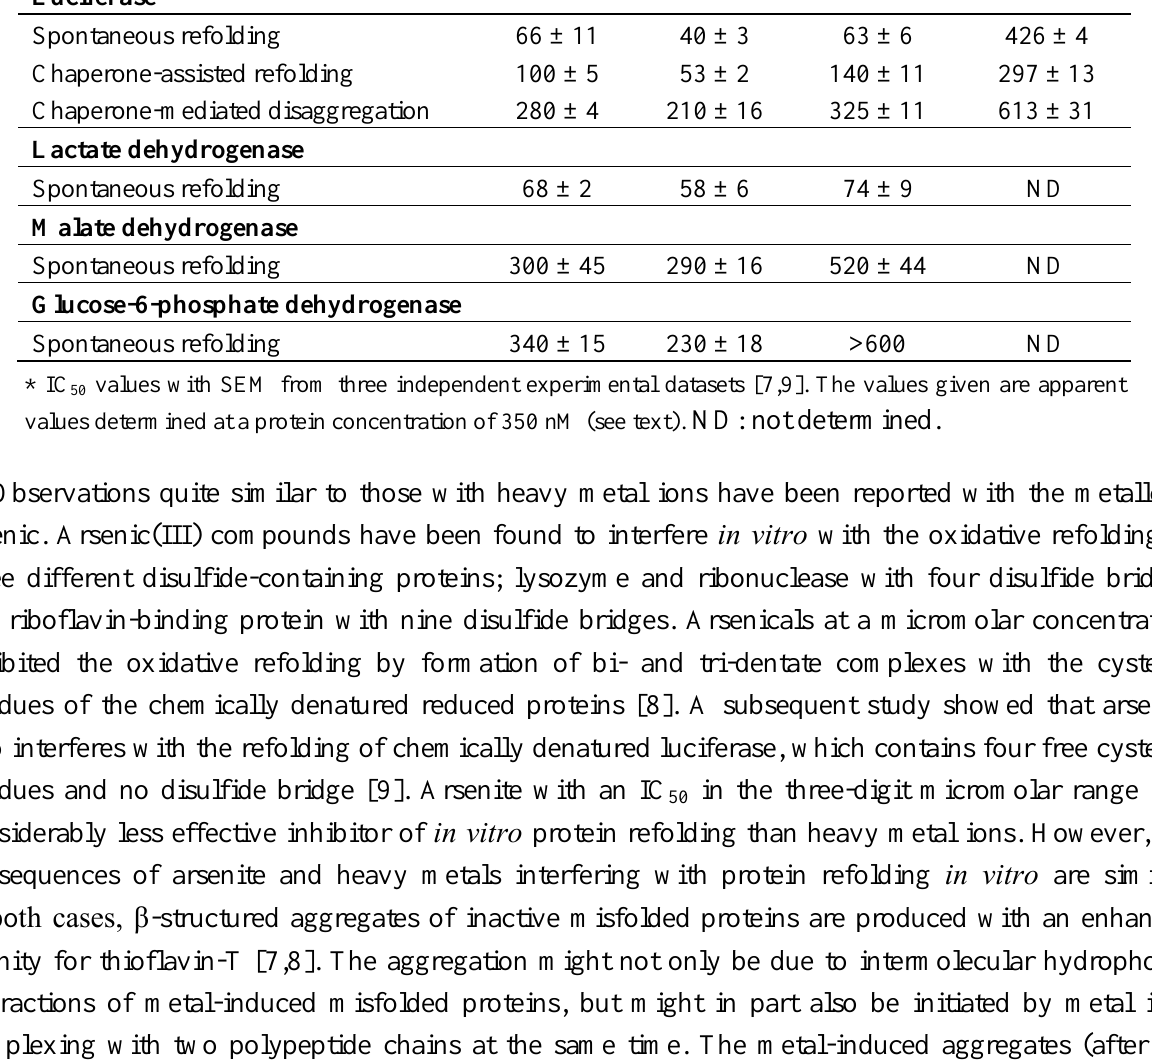
for the inhibition of protein refolding. 2